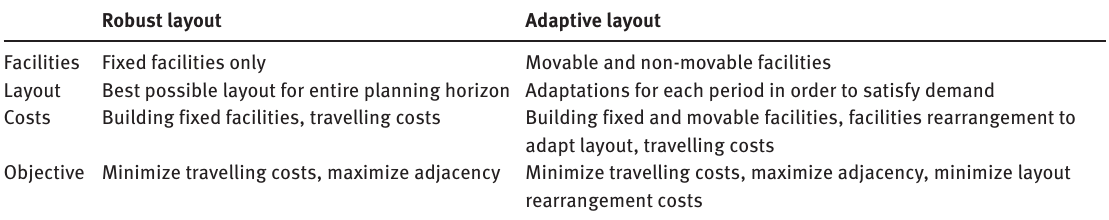
Table 1: Robust Layout vs. Adaptive